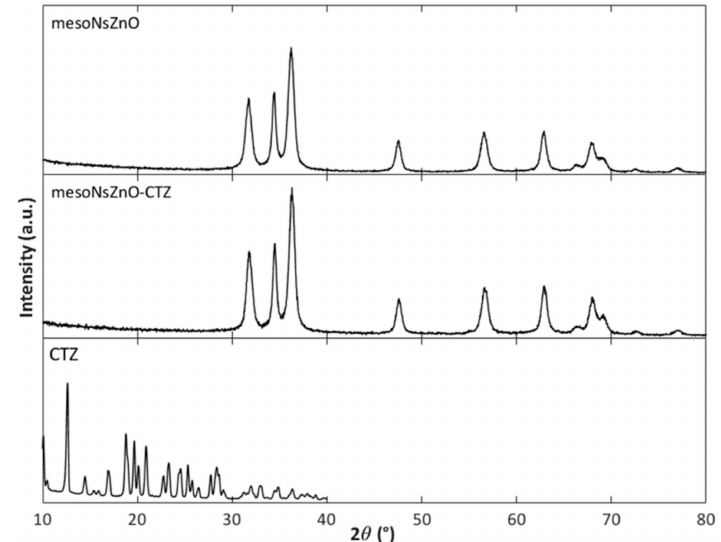
Figure 6. XRD patterns: MesoNsZnO carrier, mesoNsZnO-CTZ system, CTZ.